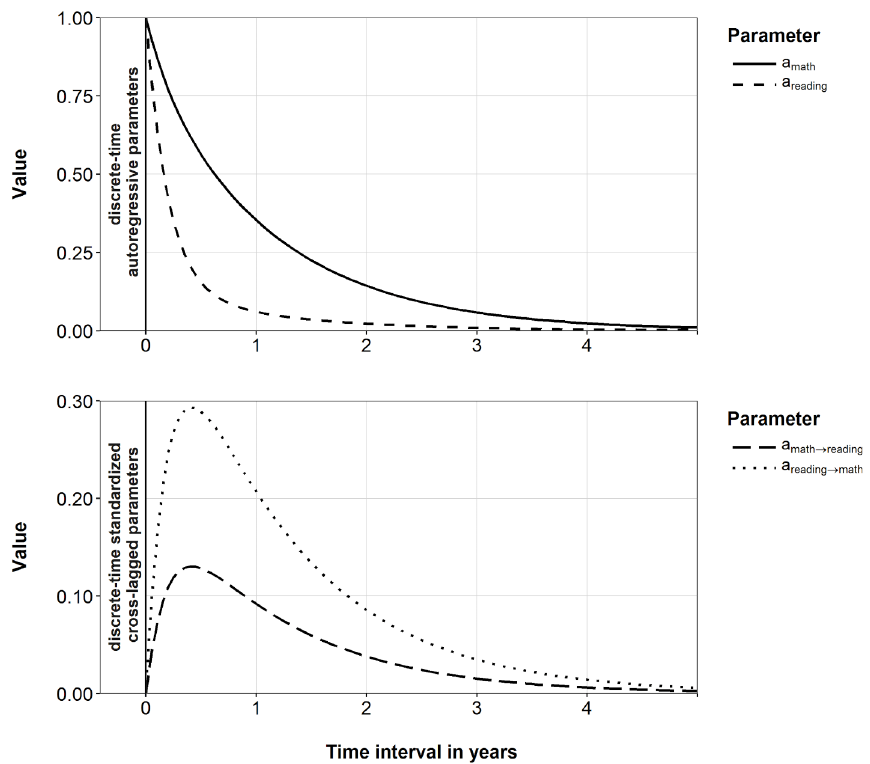
Fig. 1 - Discrete-time autoregressive and cross-lagged parameters for varying time